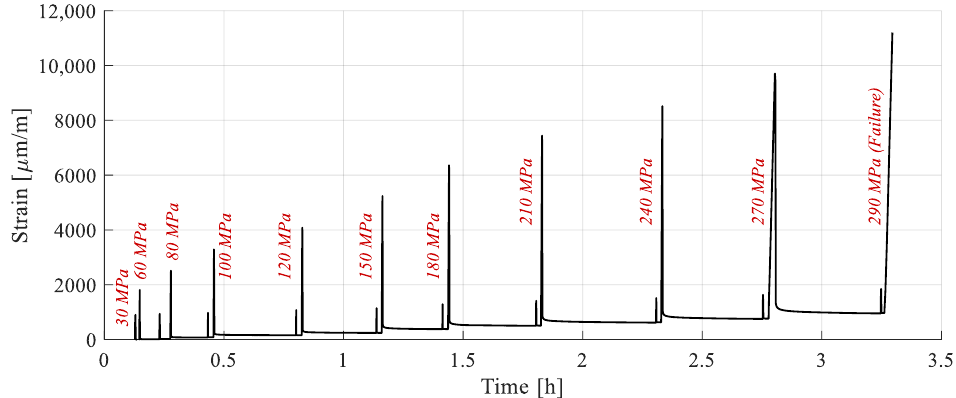
Figure 10. Strain response of a sample subjected to repeated progressive load tests.